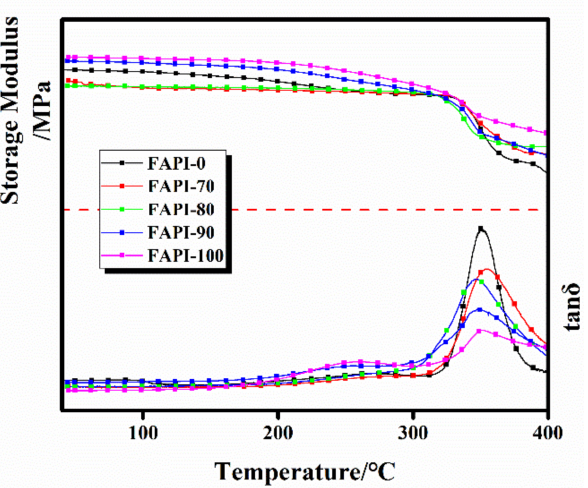
Figure 6. DMA curves of the FAPI films with different biphenyl content in polymer backbone.